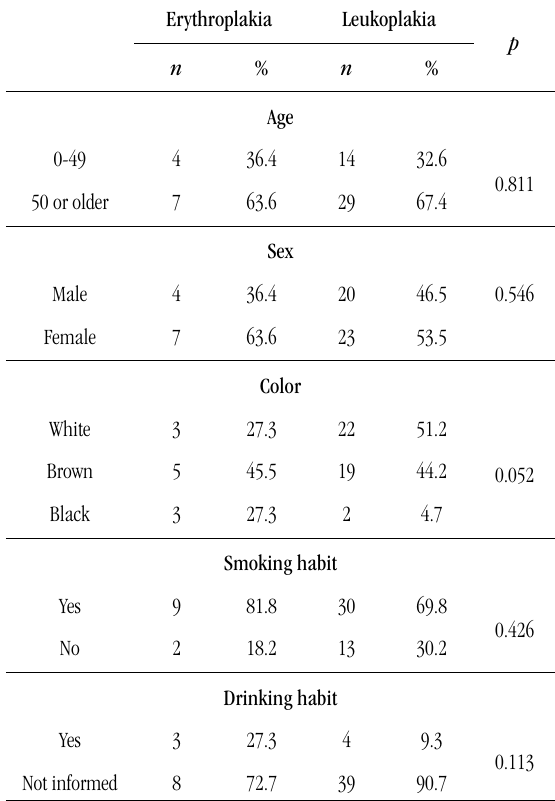
tABLE 1 – Socio-demographic features and habits